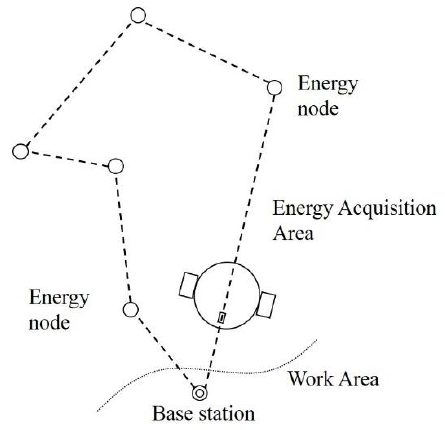
Figure 1. Robot activity space.